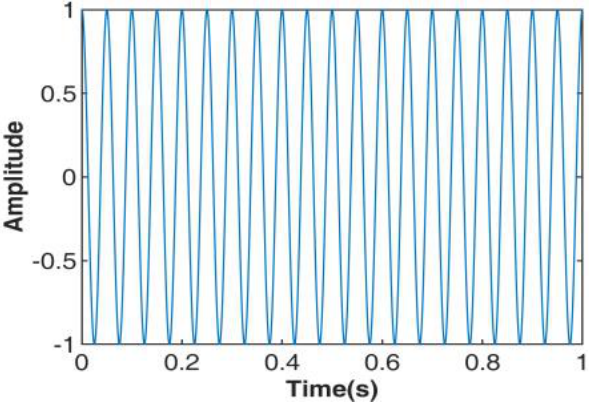
Figure 2. Time domain representation of harmonic signal.